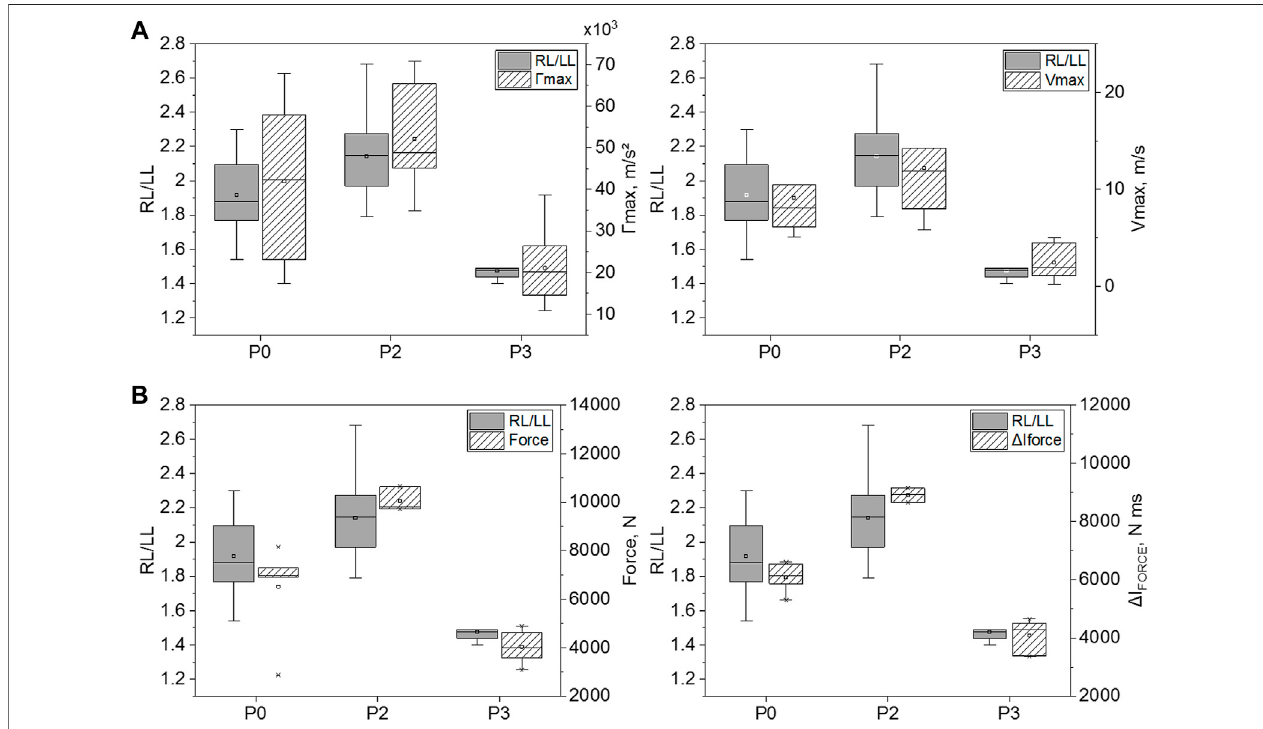
FIGURE 9 | Comparison of the evolution of the lung injury risk for P0, P2, and P3 with (A) the swine chest wall motion (chest acceleration and velocity) and (B) BOPMAN measured Force and Δ I FORCE .